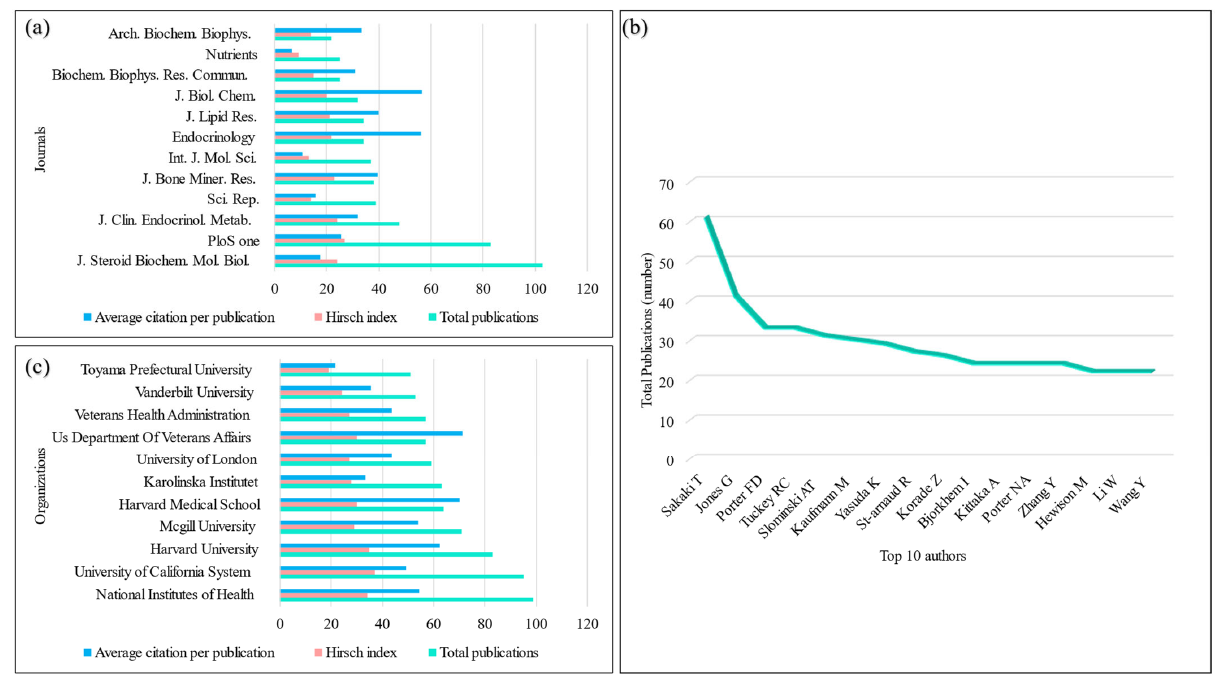
Figure 2. Average citations per publication, H ‐ index, and total publications for top productive ( a ) journals and ( c ) affiliations; ( b ) Top 10 productive authors in vitDMGPs research.